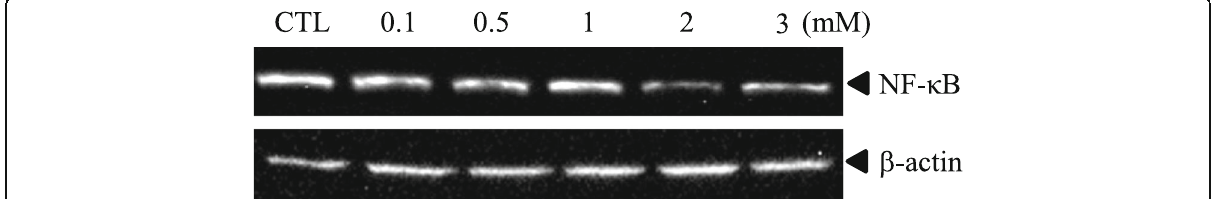
Fig. 3 Effect of 10-HDA on human NF- κ B production in WiDr cells. Supernatants of WiDr cultures, treated with or without 10-HDA (0.1, 0.5, 1, 2 and 3 mM), were collected after 24 h and tested by Western Blotting to detect the presence of NF- κ B. CTL represents the control group (without 10-HDA). Results are expressed as relative percentages of NF- κ B activation compared to the control